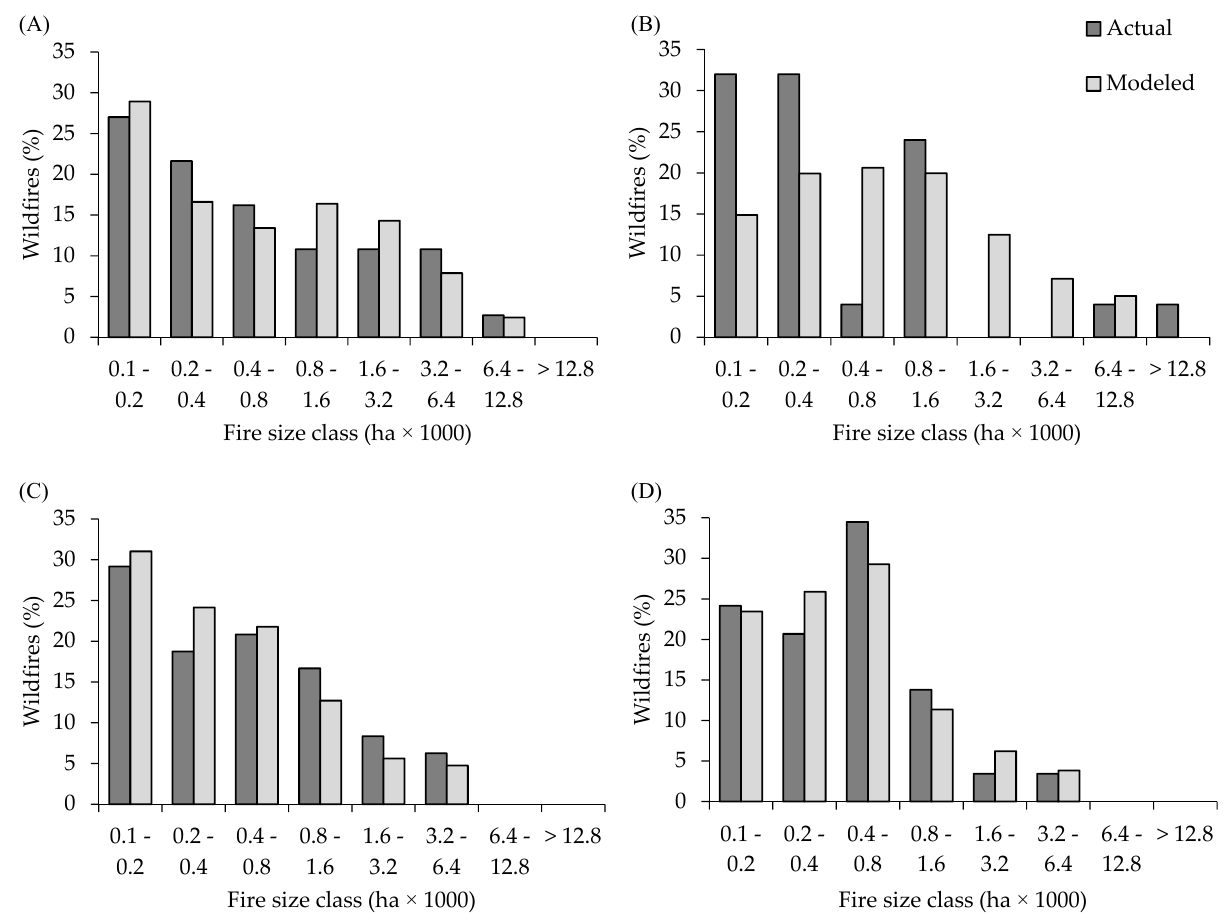
Figure A2. Fire spread model calibration in the different fire modeling domains. Histograms show the fire size distribution for actual (1883 to 2015) and modeled large fires (>100 ha). In planning area 4 ( A ), 29 historical events had a 1244 ha average fire size, and modeled fires had an average fire size of 1216 ha. In planning areas 2 and 3 ( B ), 25 historical events had a 1453 ha average fire size, and the modeled fires 1428 ha. In planning areas 5 and 6 ( C ), 48 historical events had a 780-ha average fire size, and the modeled fires had an average fire size of 779 ha. In planning area 1 ( D ), 29 historical events had a 695-ha average fire size, and the modeled fires had an average fire size of 699